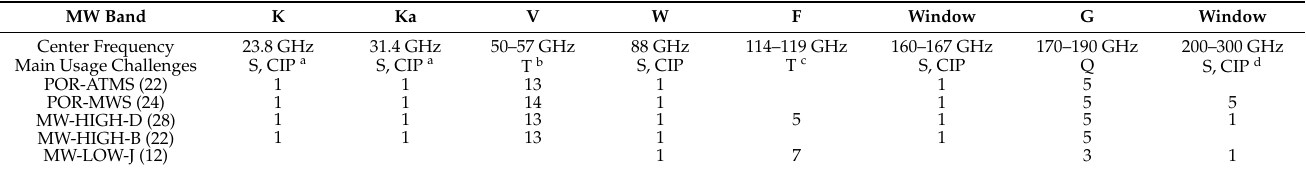
Table 1. Coverage of MW bands for assessed sensors. Values in the table correspond to the number of channels in each band and the total number of channels for each sensor are shown in parenthesis. In the table, S denotes surface, T denotes temperature, Q denotes moisture, C denotes cloud, I denotes ice, and P denotes precipitation.